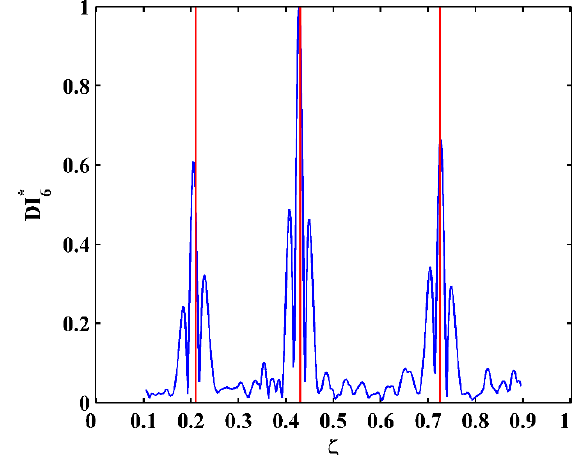
Figure 18. NMDIs for the ( a ) third, ( b ) fourth, and ( c ) fifth mode shapes (locations of cracks are indicated by red lines).